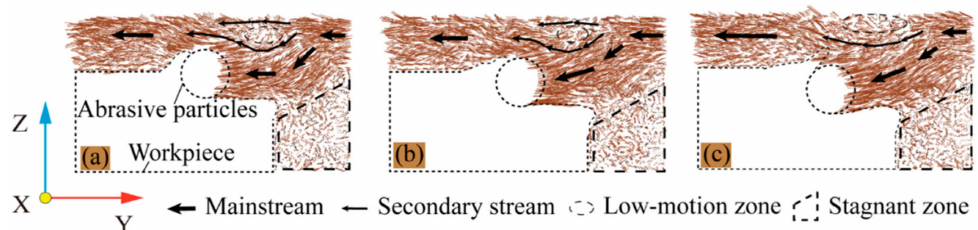
Figure 3. The instantaneous movement distributions of the fluid medium at a cutting distance of 80 Å. ( a ) θ = 0 ◦ ; ( b ) θ = 5 ◦ ; and ( c ) θ = 10 ◦